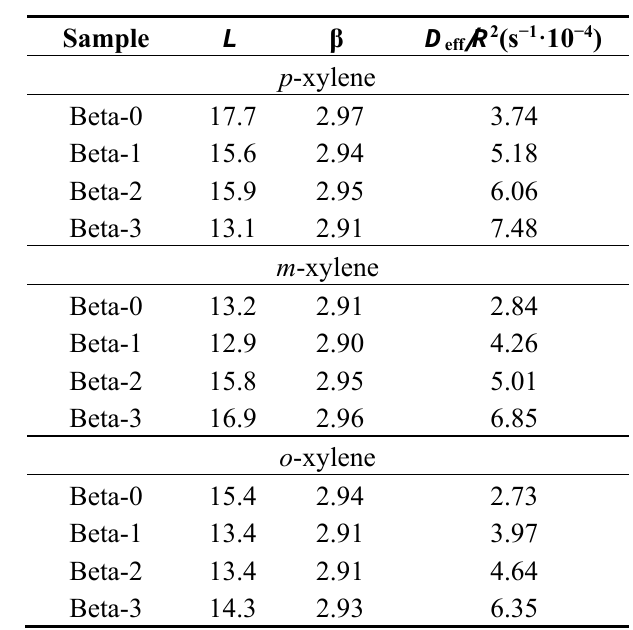
Table 5. Zero length column (ZLC) fitting data for xylene isomers on Beta zeolite samples at 373 K.